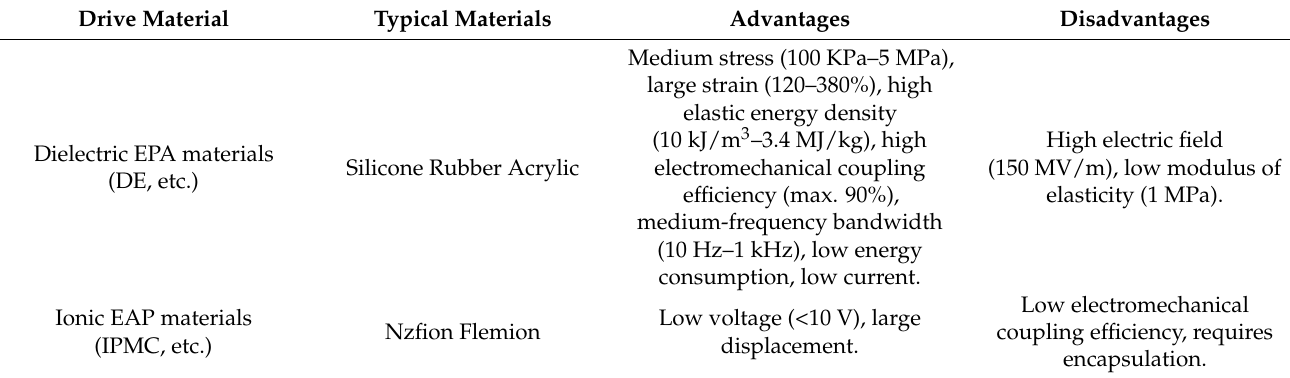
Table 2. Comparison of the performance of dielectric and ionic EAP